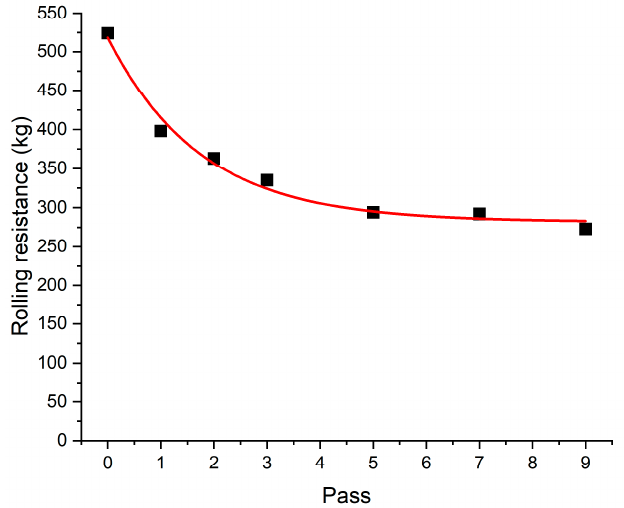
Figure 16. Rolling resistance collected after the number of passes.